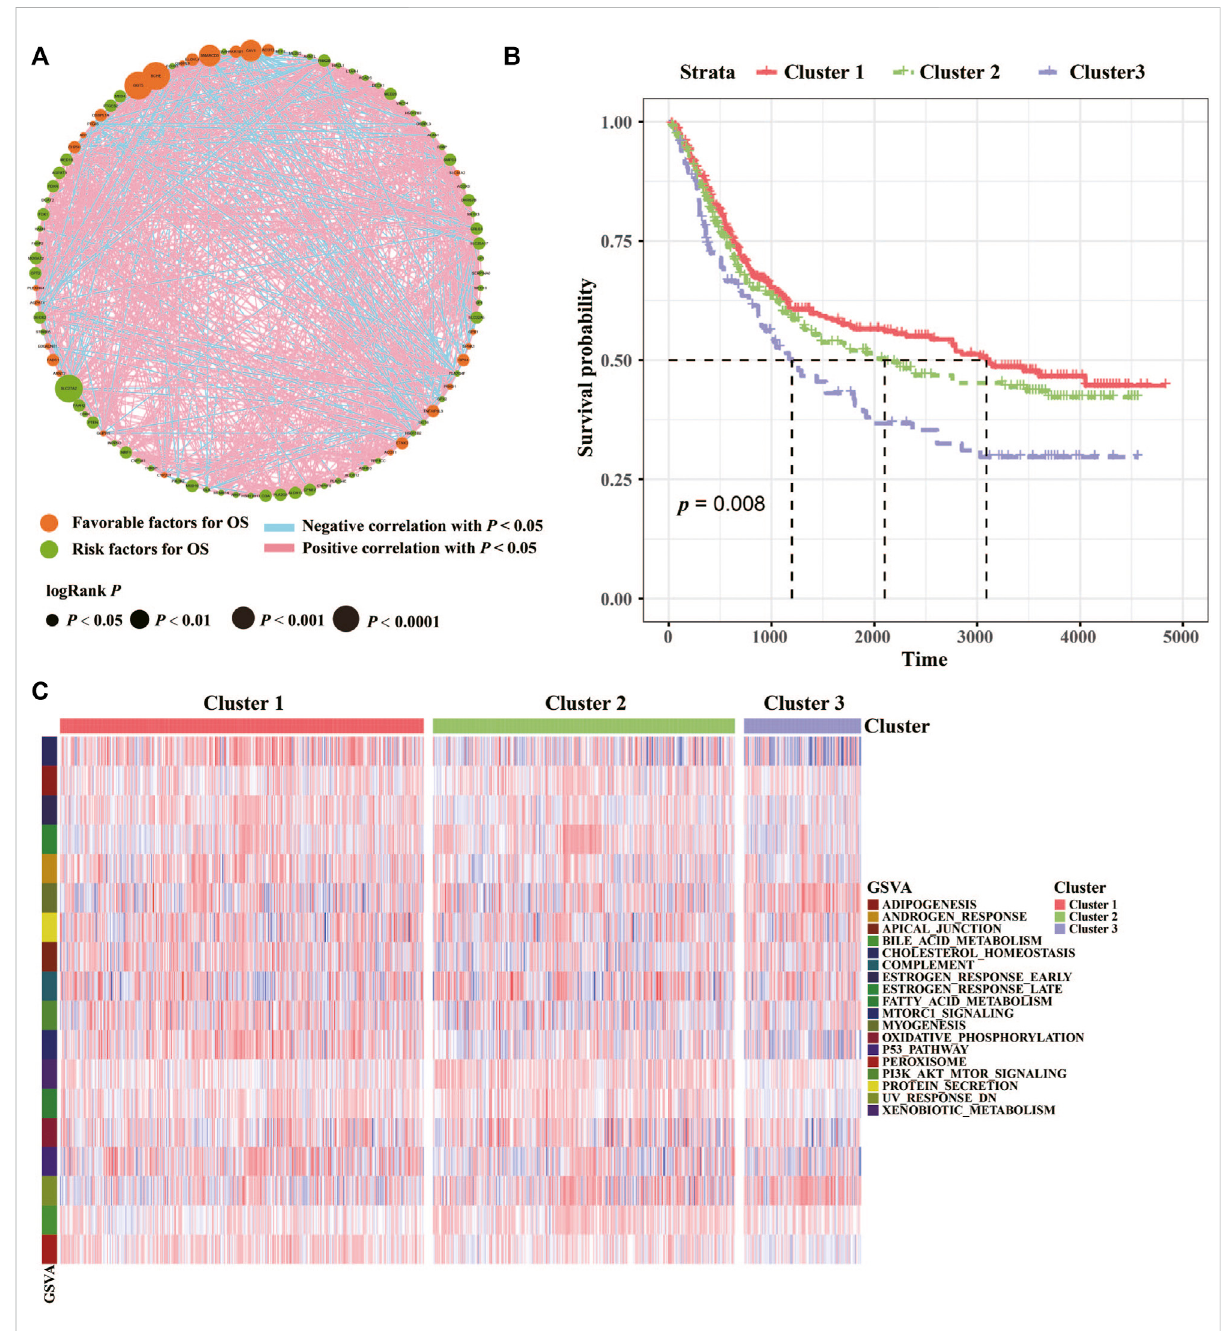
FIGURE 1 Characterizations of lipid metabolism in GC. (A) Cellular interactions of lipid metabolism in GC. The size of each cell represents the survival impact of each lipid metabolism gene. Favorable factors for OS, green circle; Risk factors for OS, orange circle. Positive correlation, red square; Negative correlation, blue square. (B) The association betweenlipid metabolism patterns and OS of 768patients intheTCGA and GEO datasets. And the log-rank test shows an overall p < 0.05. (C) GSVA (gene set variation analysis) between the three clusters. Cluster 1, red; Cluster 2, green; Cluster 3,